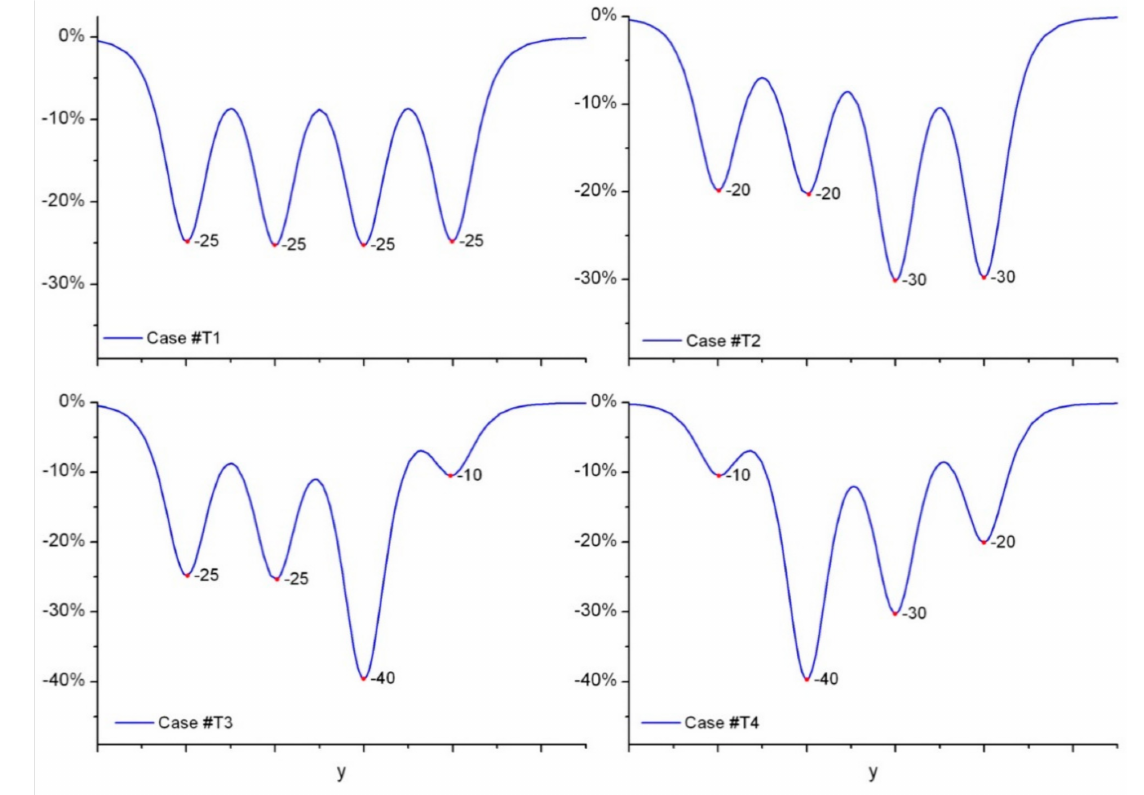
Figure 5. Examples of load distributions under wheels for cases #T1 to #T4 based on the Flamant model (local loads/peak values of loads are expressed as a percentage of the total loading, y—coordinate according to Figure